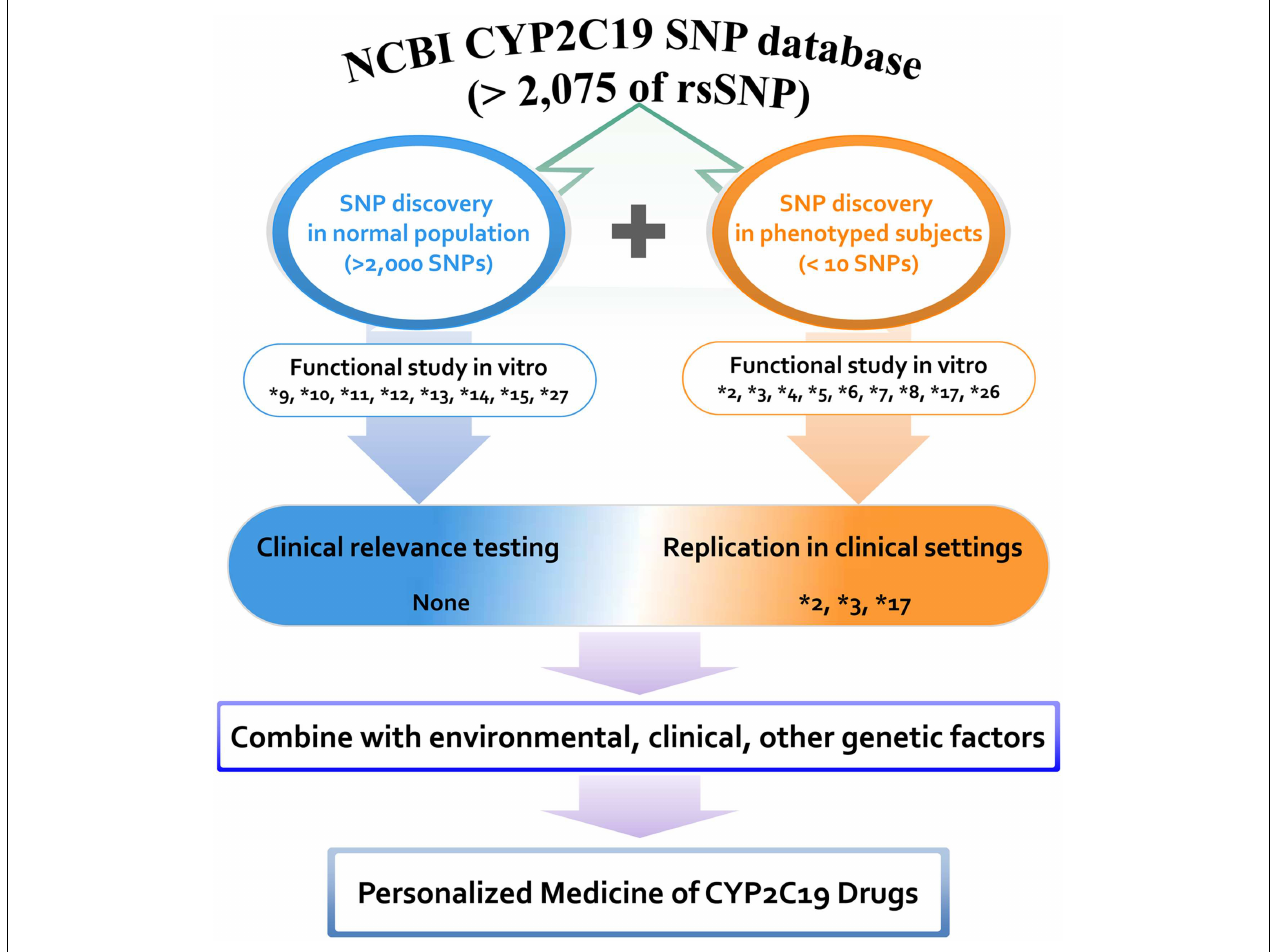
the present stage. Among them the number of SNPs that are functionally studied in vitro and validated in vivo is limited. Proposed scheme is for the personalized medicine of CYP2C19 substrate drugs.